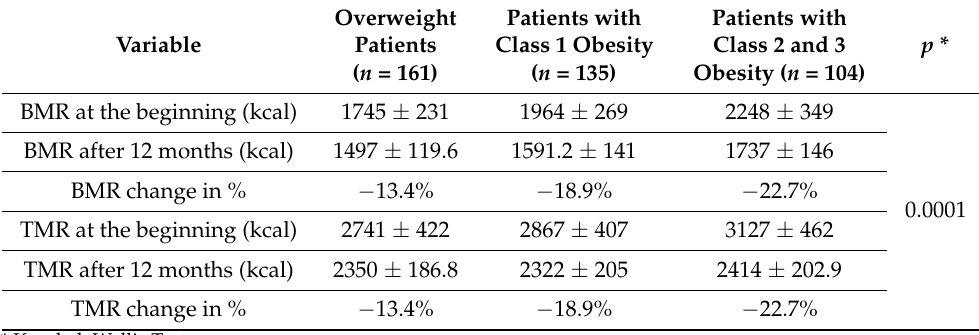
Table 6. Change in basal metabolic rate (BMR) and total metabolic rate (TMR) after 12 months of